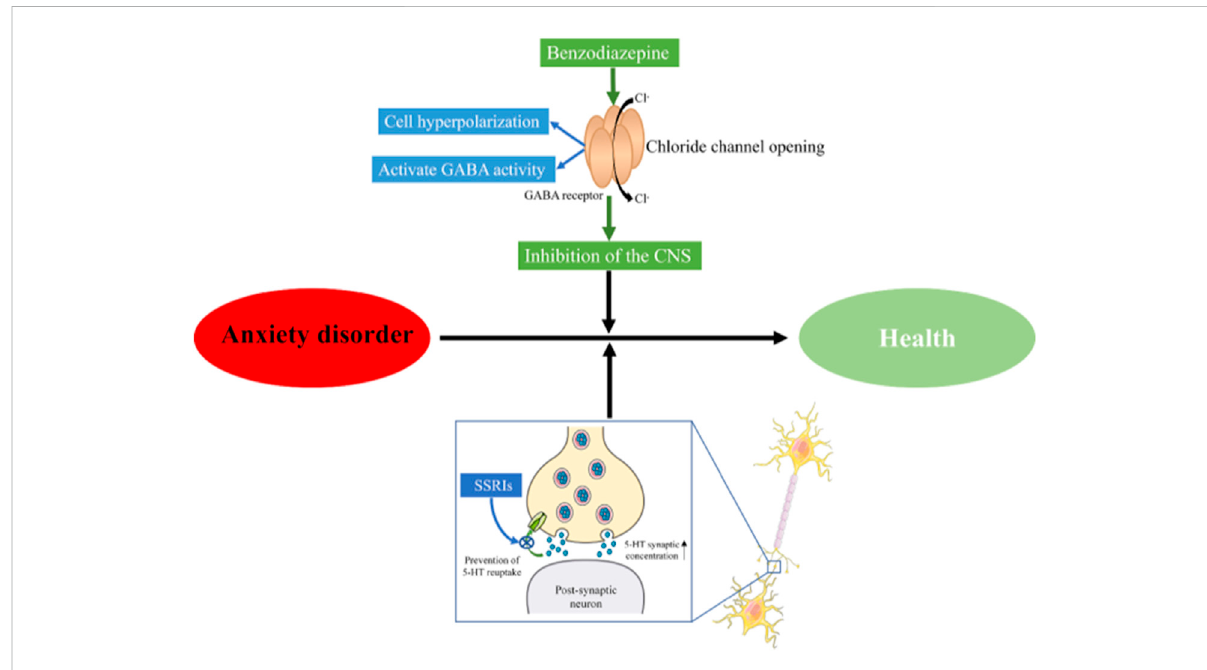
FIGURE 1 Mechanism of antianxiety action. CNS, Central Nervous System; SSRIs, selective serotonin reuptake